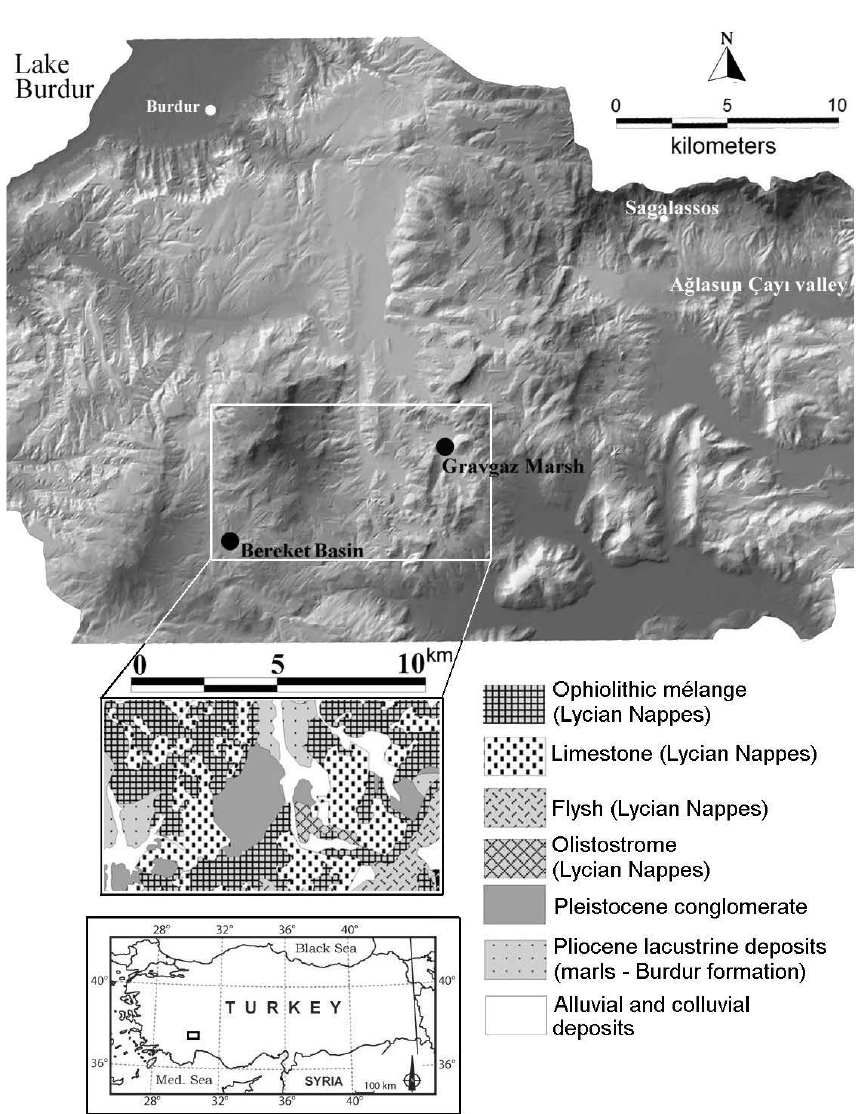
Fig. 2. A DEM and geological map of the main part of the territory of Sagalassos with the position of the coring